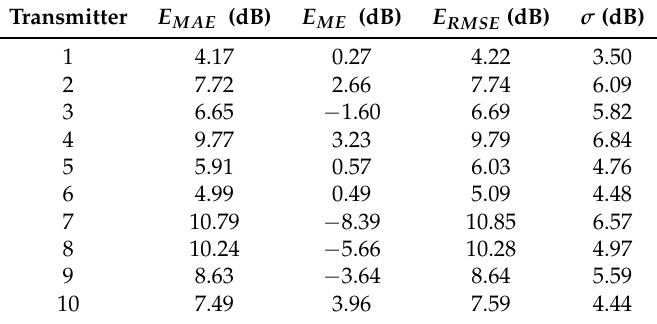
Table 3. Validation results of office environment 2.